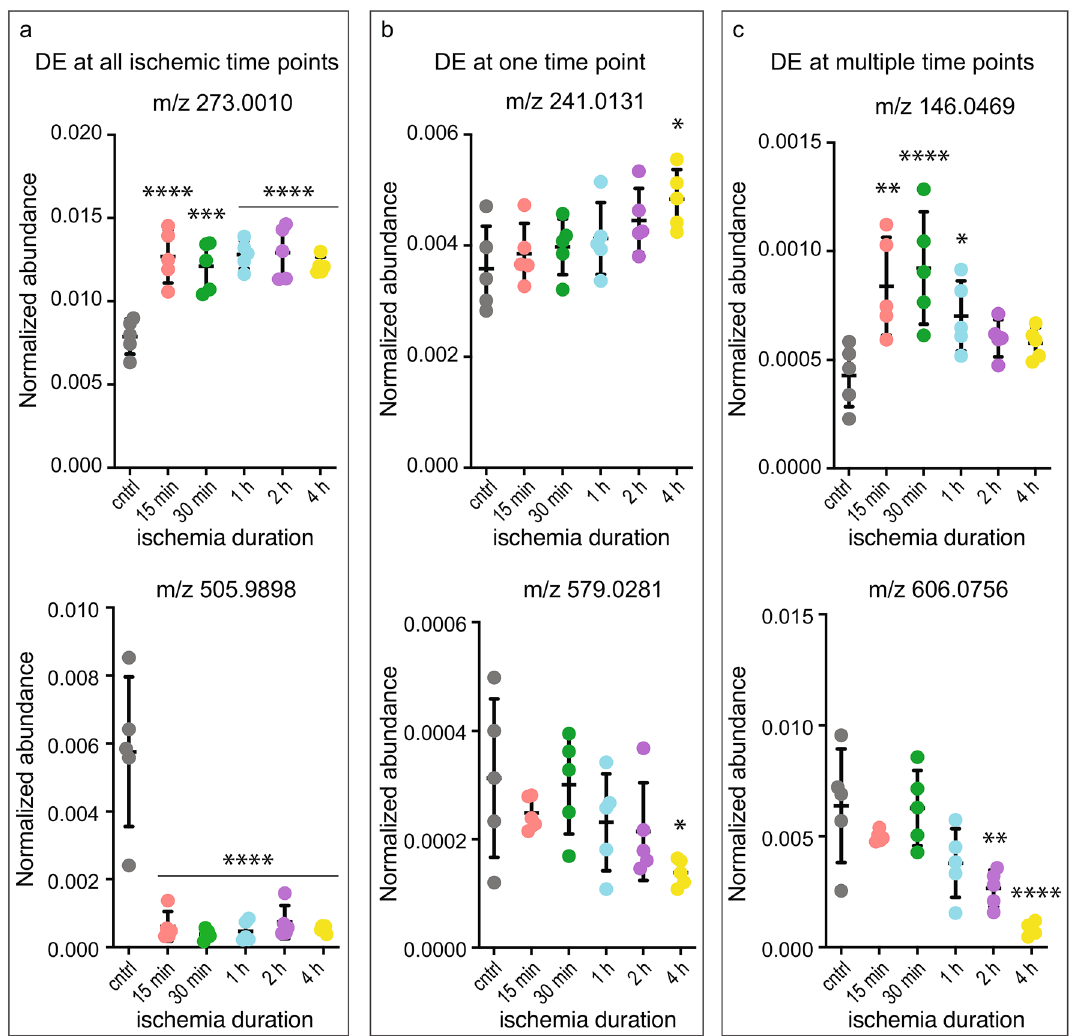
Figure 3. Temporal patterns of selective annotated DE features (mean normalized abundance from ROI 1 ± SD). Features were differentially expressed either ( a ) at all time points: m/z 273.0010 (possibly d-glucuronic acid 1-phosphate) and m/z 505.9898 (possibly ATP 505.9898), up- and down-regulated respectively, ( b ) only at one time point: m/z 241.0131 (possibly inositol cyclic phosphate) and m/z 579.0281 (possibly UDP-glucuronic acid), up- and down-regulated respectively, or ( c ) at multiple time points: m/z 146.0469 (possibly l-glutamic acid) and m/z 606.0756 (possibly UDP-N-acetylglucosamine), up- and down-regulated respectively; n = 5